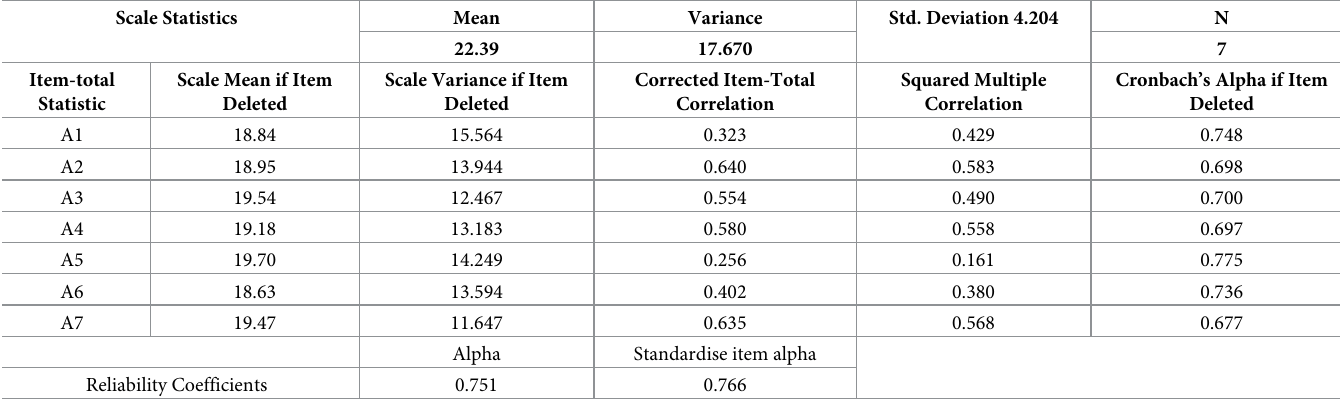
Table 3. Item analysis from SPSS output.